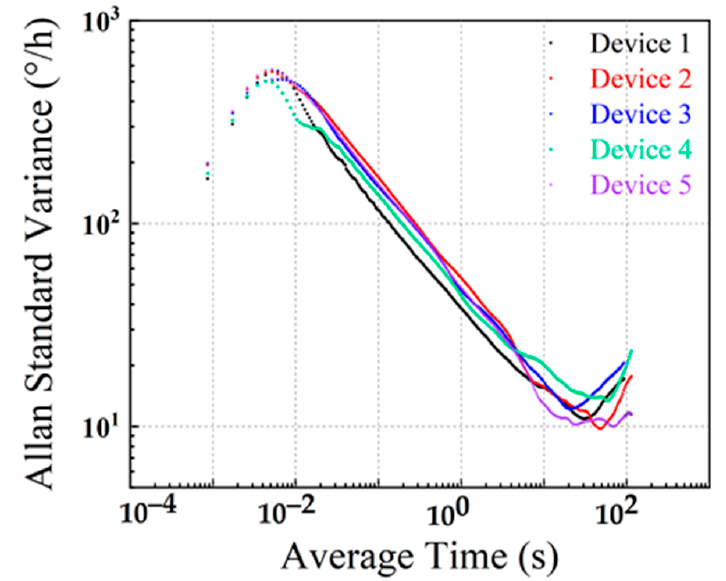
Figure 12. Room-temperature ZRO results.